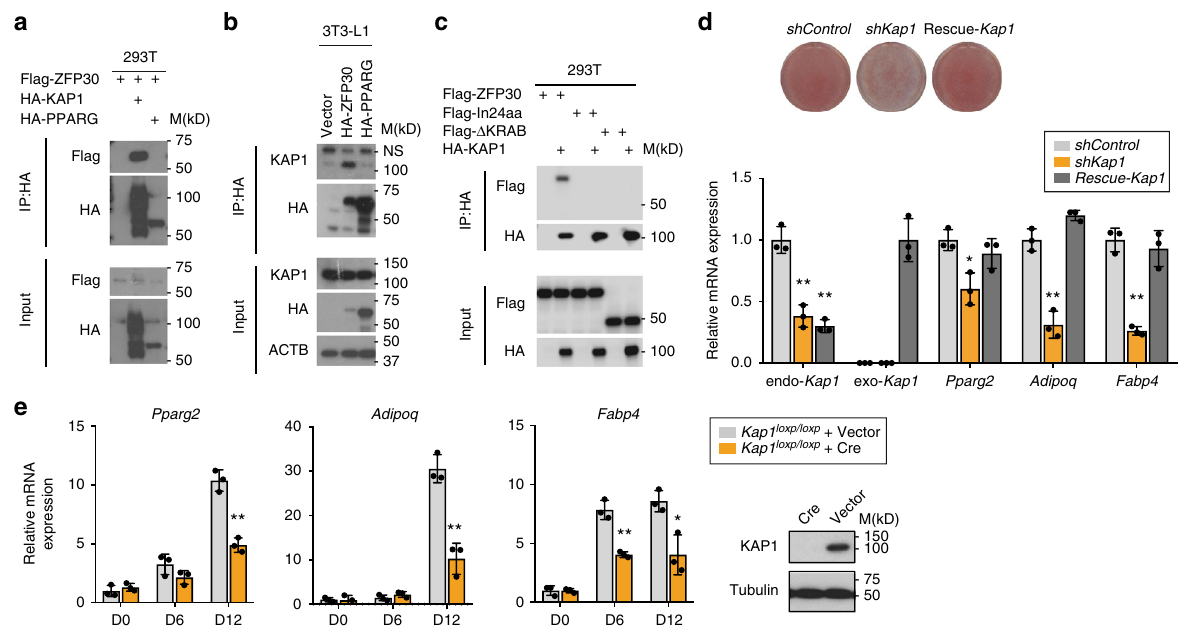
Fig. 4 KAP1 interacts with ZFP30 and promotes adipogenesis. a Immunoprecipitation in HEK293T cells showing that ZFP30 interacts with KAP1. HEK293T cells transfected with the indicated constructs were subjected to immunoprecipitation with the HA antibody and subsequently probed with the listed antibodies. b Immunoprecipitation in 3T3-L1 cells showing that ZFP30 interacts with endogenous KAP1 in adipogenic conditions. 3T3-L1 expressing the indicated HA-tagged proteins were used for immunoprecipitating HA and subsequent western blotting with the listed antibodies. NS, non-speci fi c band. c Immunoprecipitation in HEK293T cells showing that the KRAB domain of ZFP30 is essential for interaction with KAP1. Δ KRAB is a KRAB domain deletion mutant and In24aa is a mutant with a 24 amino acid insertion in the KRAB domain derived from the Zfp30 c15 allele 2. d Effect of knocking down Kap1 and of rescuing Kap1 expression on IBA adipogenic differentiation as assessed by lipid accumulation (ORO staining). The rescue of Kap1 expression was achieved by introducing an shRNA-resistant allele. The expression of endogenous and exogenous Kap1 (endo- Kap1 and exo- Kap1 , respectively), as well as adipogenic marker genes was assessed by qPCR. n = 3 biologically independent experiments. ** p < 0.01, * p < 0.05, t test, compared with shControl . e Effect of knocking out Kap1 on primary MEF adipogenic gene expression as assessed by qPCR. Lentivirus encoding Cre recombinase or control vector were introduced to Kap1 loxp/loxp MEF cells to generate Kap1 KO and control cells. KAP1 protein levels are shown on the right. n = 3 biologically